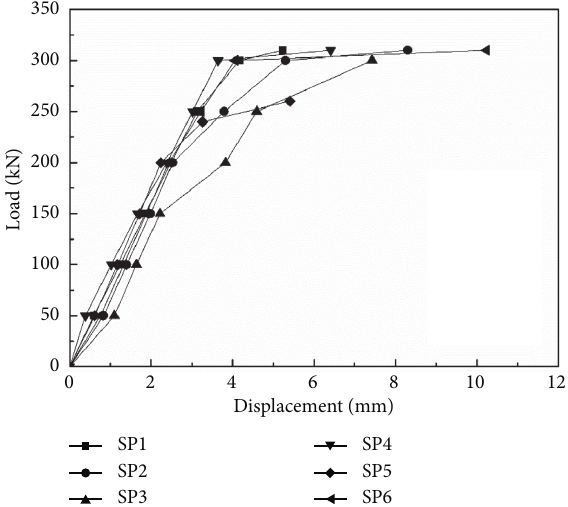
Figure 9: Specimen load-deflection curve.